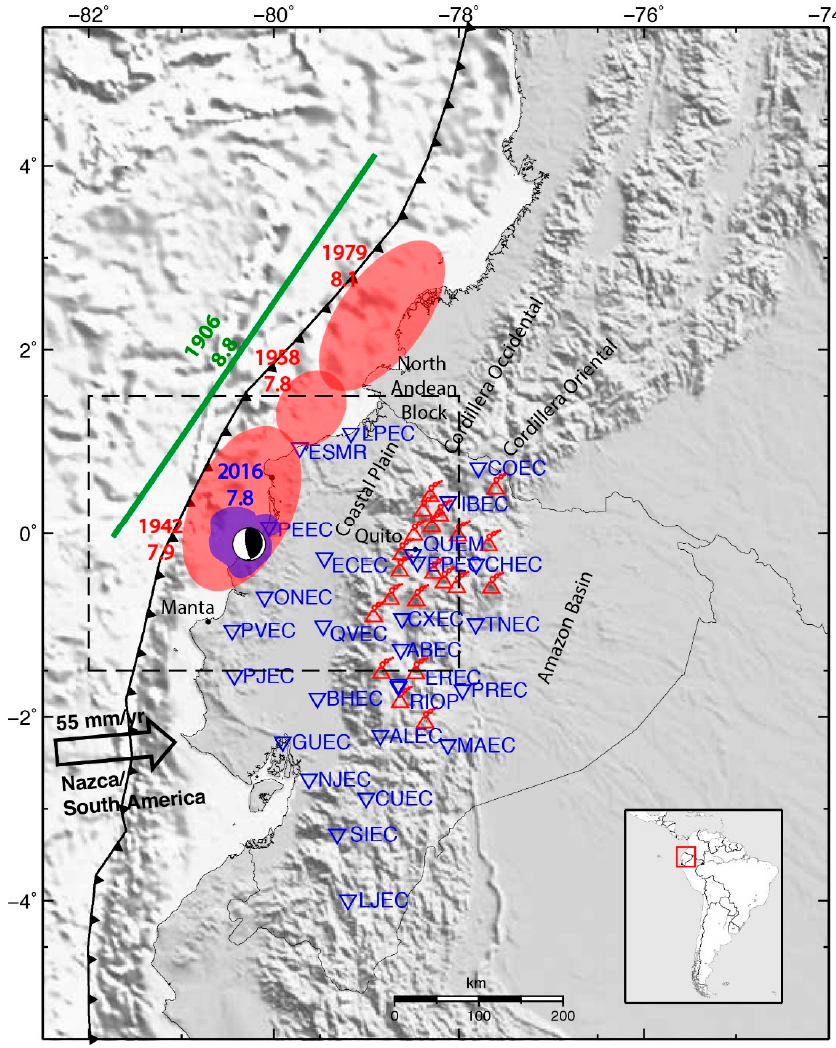
Figure 1. Reference map of our study area in Ecuador (red box in the inset map). The relative Nazca–South American convergence rate and direction are shown with a black arrow [20] and the location of the trench is shown with a heavy black barbed line. The black dashed box shows the region in Figures 2 and 4. The location of the continuous GPS sites used in this study is shown as blue inverted triangles. The Global Centroid Moment Tensor (GCMT) focal mechanism of the 2016 Pedernales earthquake is shown. The topography and bathymetry are from the ETOPO1 1 arc-minute global relief model [24]. The green segment indicates the approximate rupture area of the 1906 earthquake [25] and the red semi-transparent areas represent the rupture areas of the 1942, 1958, and 1979 earthquakes [26–29]. The approximate rupture area of the Mw 7.8 2016 Pedernales earthquake from our variable-slip model is also shown (semi-transparent blue area).